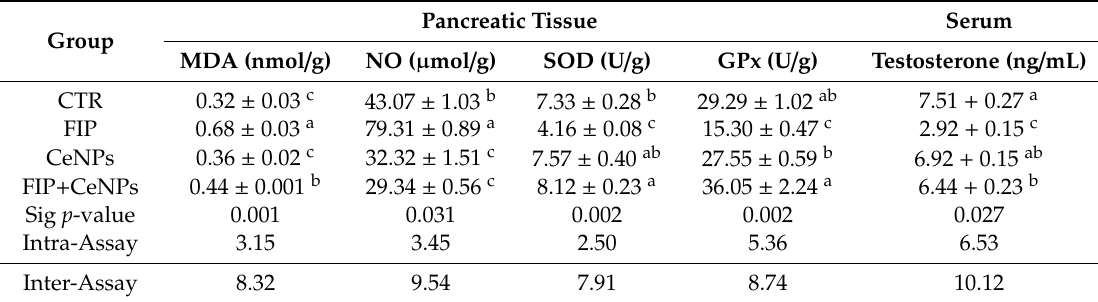
Table 4. Pancreatic lipid peroxidation and antioxidant biomarkers, and serum testosterone in control and experiment groups and coe ffi cients of variation (CV (%); intra- and inter- assay) values of tested biochemical and hormonal